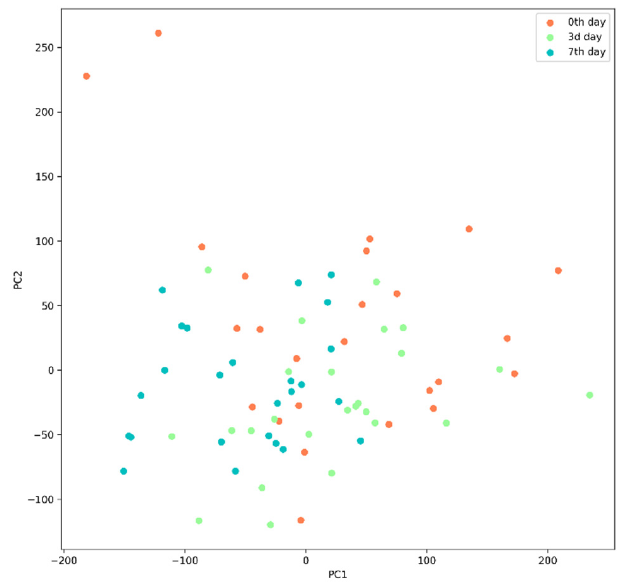
Figure 9. Amino acid levels in blood serum before and on days 3 and 7 after the TBI. We used the Wilcoxon test method to compare amino acid levels in blood serum on days 3 and 7 after the TBI. Table 1 shows significant associations as the mean (IQR) and p -values (differences were considered significant from a p -value of <0.00064). Table 1. Significant changes in amino acid levels in blood serum on days 3 and 7 after the TBI, compared to the baseline. Note: Significant changes are marked with an asterisk.